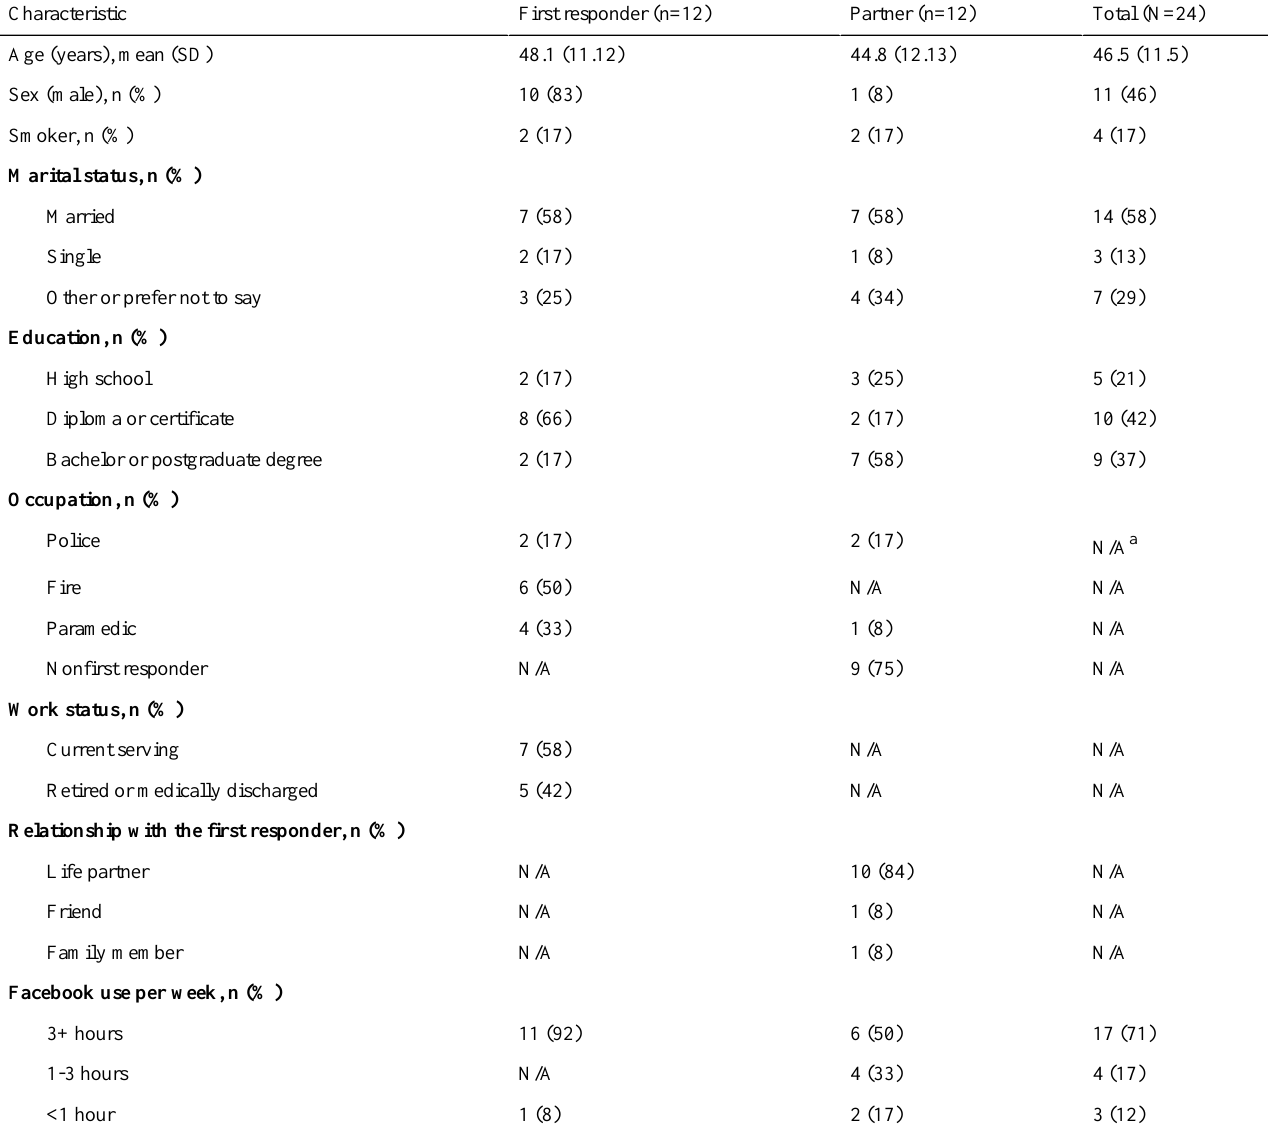
Table 2. Baseline